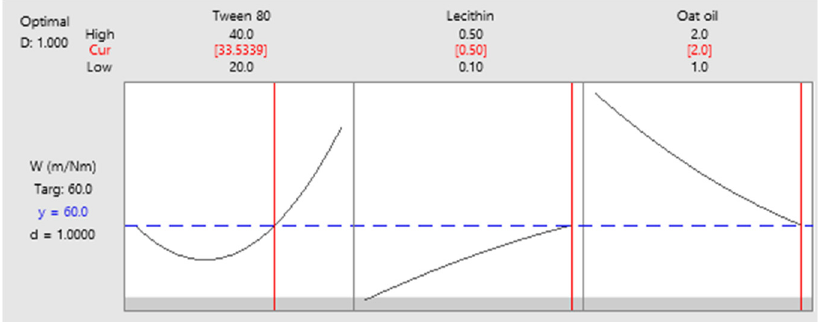
Figure 25. Predicted optimization plots for W response (Y 3 ) as function of three setting parameters: X 1 —without constraints, X 2 —without constraints, and X 3 —maximized, with a composite desirability of 1.0000.